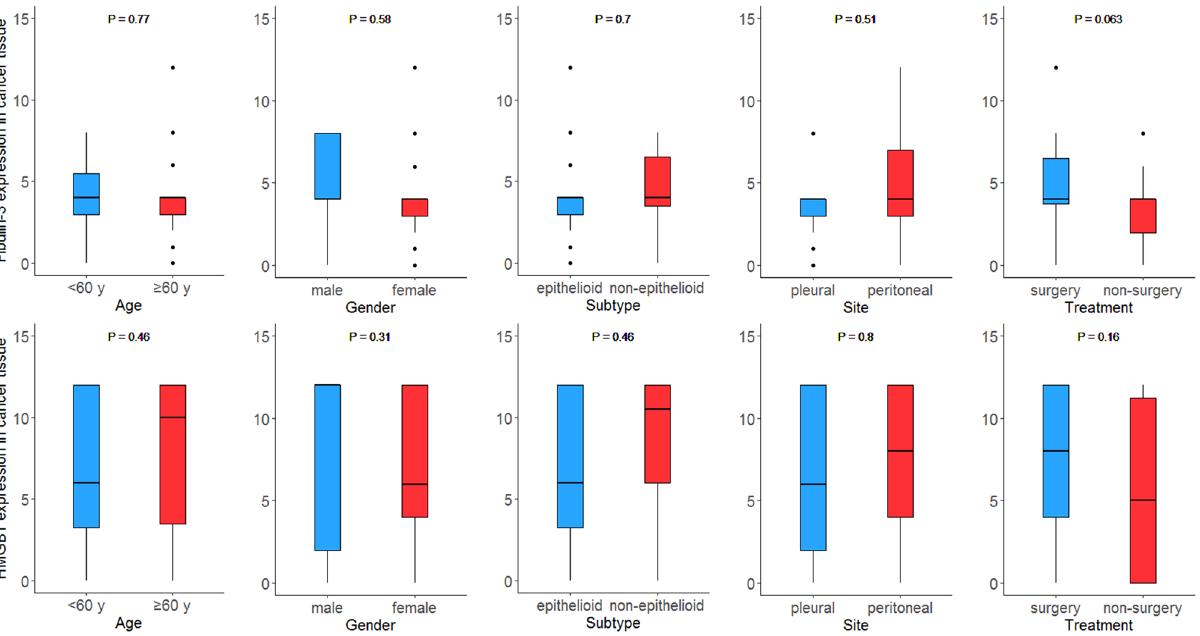
Figure 2. Expressional differences of Fibulin-3 and HMGB1 in different gender, age, type, site, and treatment methods. ( A ) Fibulin-3 positive expression in tissue across different age. ( B ) Fibulin-3 positive expression in tissue across different gender. ( C ) Fibulin-3 positive expression in tissue across different type. ( D ) Fibulin-3 positive expression in tissue across different site. ( E ) Fibulin-3 positive expression in tissue across different treatment. ( F ) HMGB1 positive expression in tissue across different age. ( G ) HMGB1 positive expression in tissue across different gender. ( H ) HMGB1 positive expression in tissue across different type. ( I ) HMGB1 positive expression in tissue across different site. ( J ) HMGB1 positive expression in tissue across different treatment.